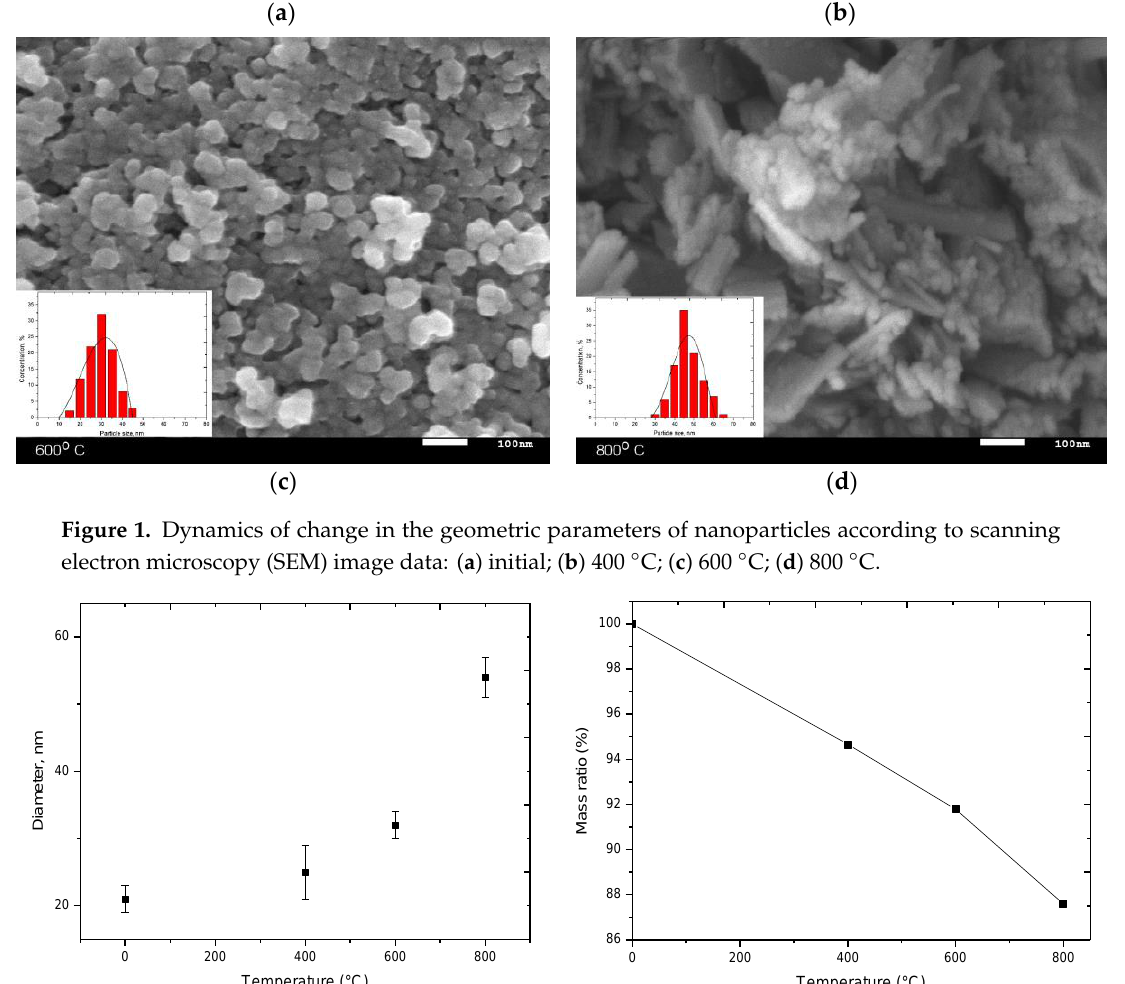
Figure 1. Dynamics of change in the geometric parameters of nanoparticles according to scanning electron microscopy (SEM) image data: ( a ) initial; ( b ) 400 °C; ( c ) 600 °C; ( d ) 800 °C.